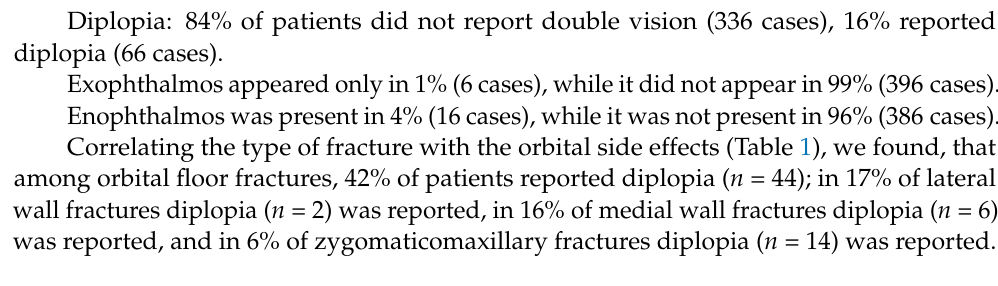
Figure 3. Orbital side effects. Diplopia: 84% of patients did not report double vision (336 cases), 16% reported diplopia (66 cases).